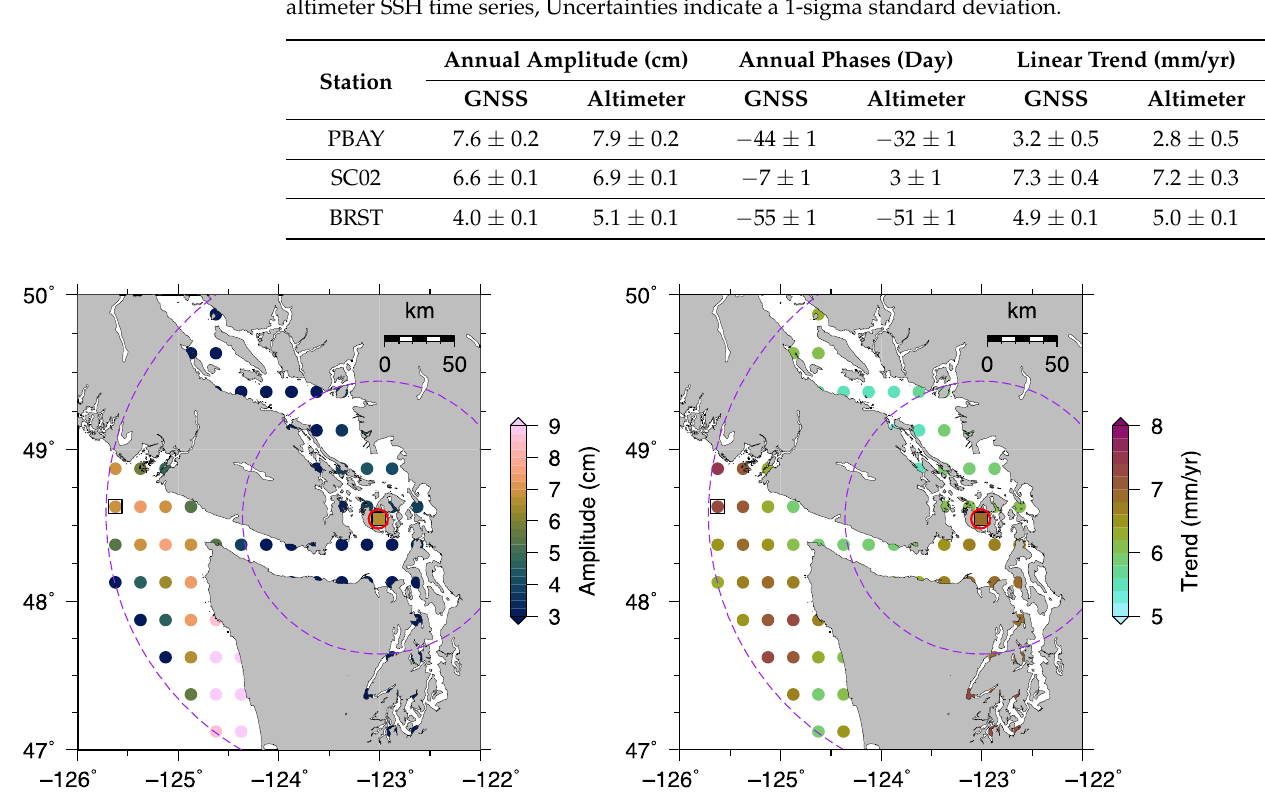
Figure 4. Annual amplitudes ( left panel ) and linear trends ( right panel ) estimated from the satellite altimeter data within 100 km from PBAY. The filled square represents the GNSS station while the filled red circle is the tide gauge. The colored dot with a black square is the grid point from which the de-seasoned and de-trended satellite altimeter data has the highest correlation coefficient with those from the coastal GNSS.